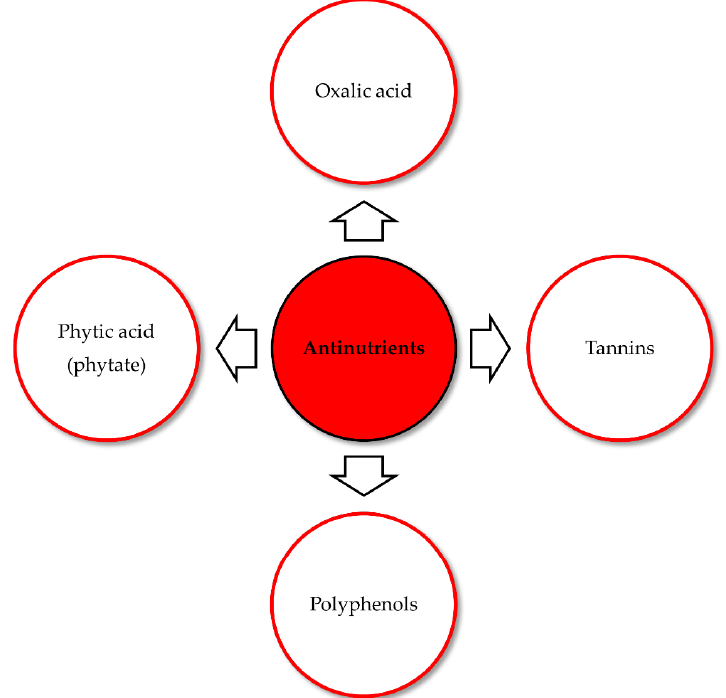
Figure 4. Antinutrients for human essential elements intake.